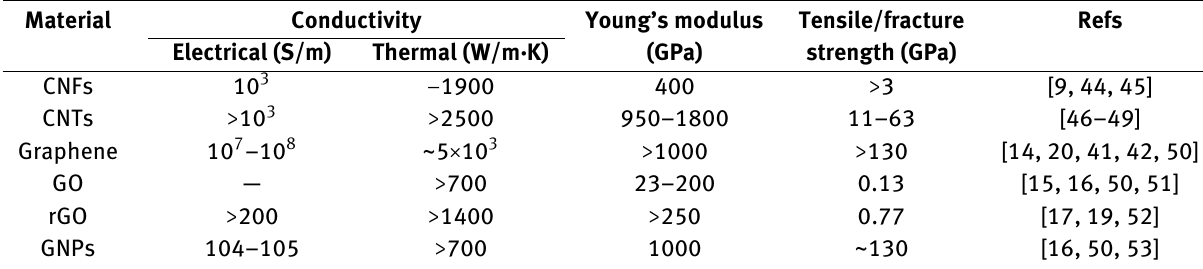
Table 1: Carbon nanomaterials and their material properties